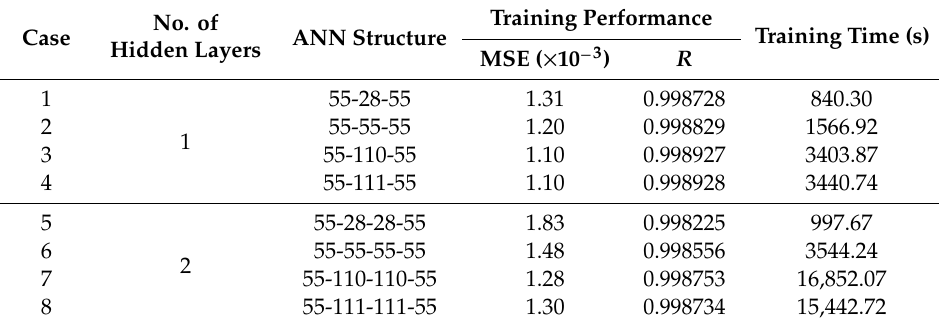
Table 5. Training results by ANN